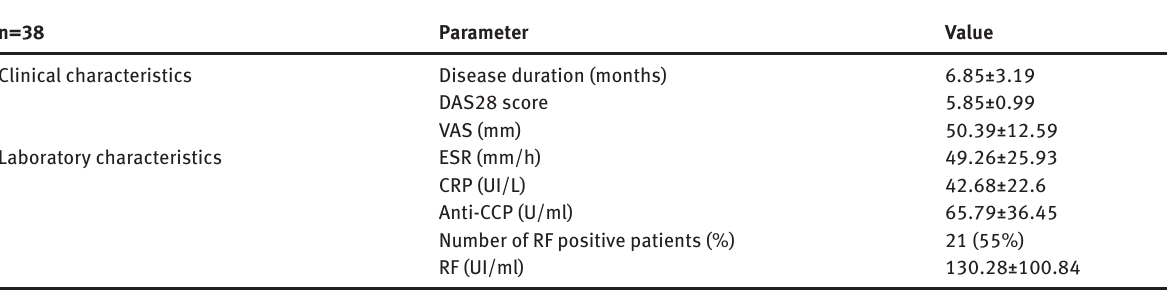
Table 2. Clinical and laboratory characteristics of patients with early RA